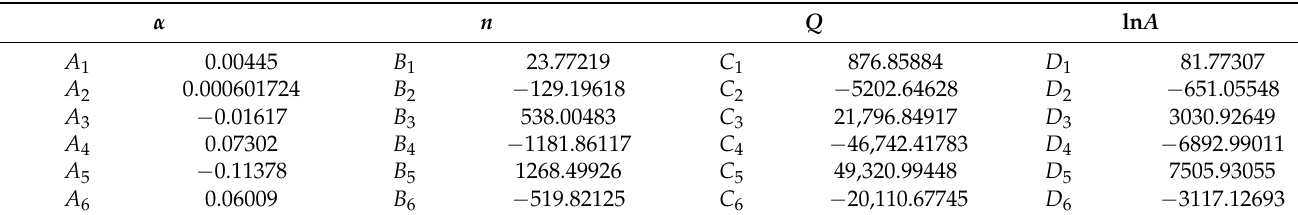
Table 2. Polynomial fitting parameters for Mo–1.5wt% ZrO 2